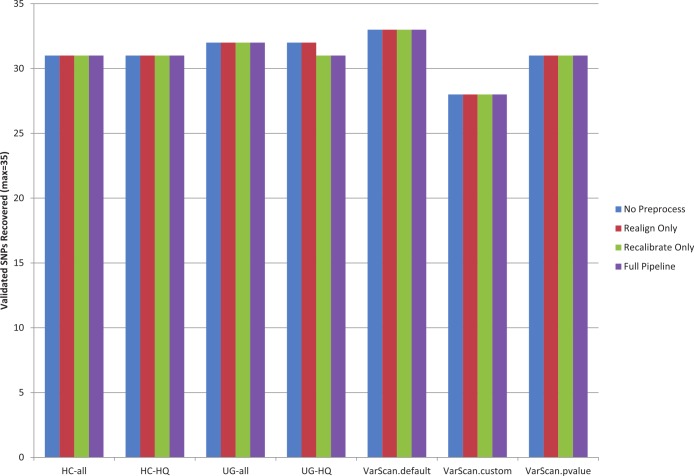
Recovery of 1KG 454 PCR validated SNPs (chr20).A pooled set of 35 validated variant from the 1000 Genomes exome sample characterized in this study (n = 12) was used to assess the sensitivity of various variant calling algorithms. The 1000 Genomes targeted exon samples were not compared because no validated variants were covered in targeted regions for that design. Seven variant calling strategies were tested (GATK UnifiedGenotyper and HaplotypeCaller, with and without filtering low quality variants; VarScan with 3 sets of parameters, see Methods). “VarScan-Cons” is the most conservative set of parameters for VarScan. Each variant caller was also tested with 4 preprocessing conditions: variants called using both GATK indel realignment and quality score recalibration (“Full Pipeline”—purple), indel realignment only (“Realign Only”—red), quality score recalibration only (“Recalibrate Only”—green), or neither (“No Preprocess”—blue). Publically available validated variants are only available for chr20, so this is the maximum number of validated SNPs that can be characterized for these samples. The validation status for each individual SNP under each variant calling condition is provided in Table S7. Validated variants were never called for chr20:3193991 for individual NA18505 (exome sample SRX237141, covered 81× with the reference allele in all reads) or for chr20:57769739 for individual NA18532 (exome sample ERR031956, not covered by any reads but located in the coding sequence for ZNF831).